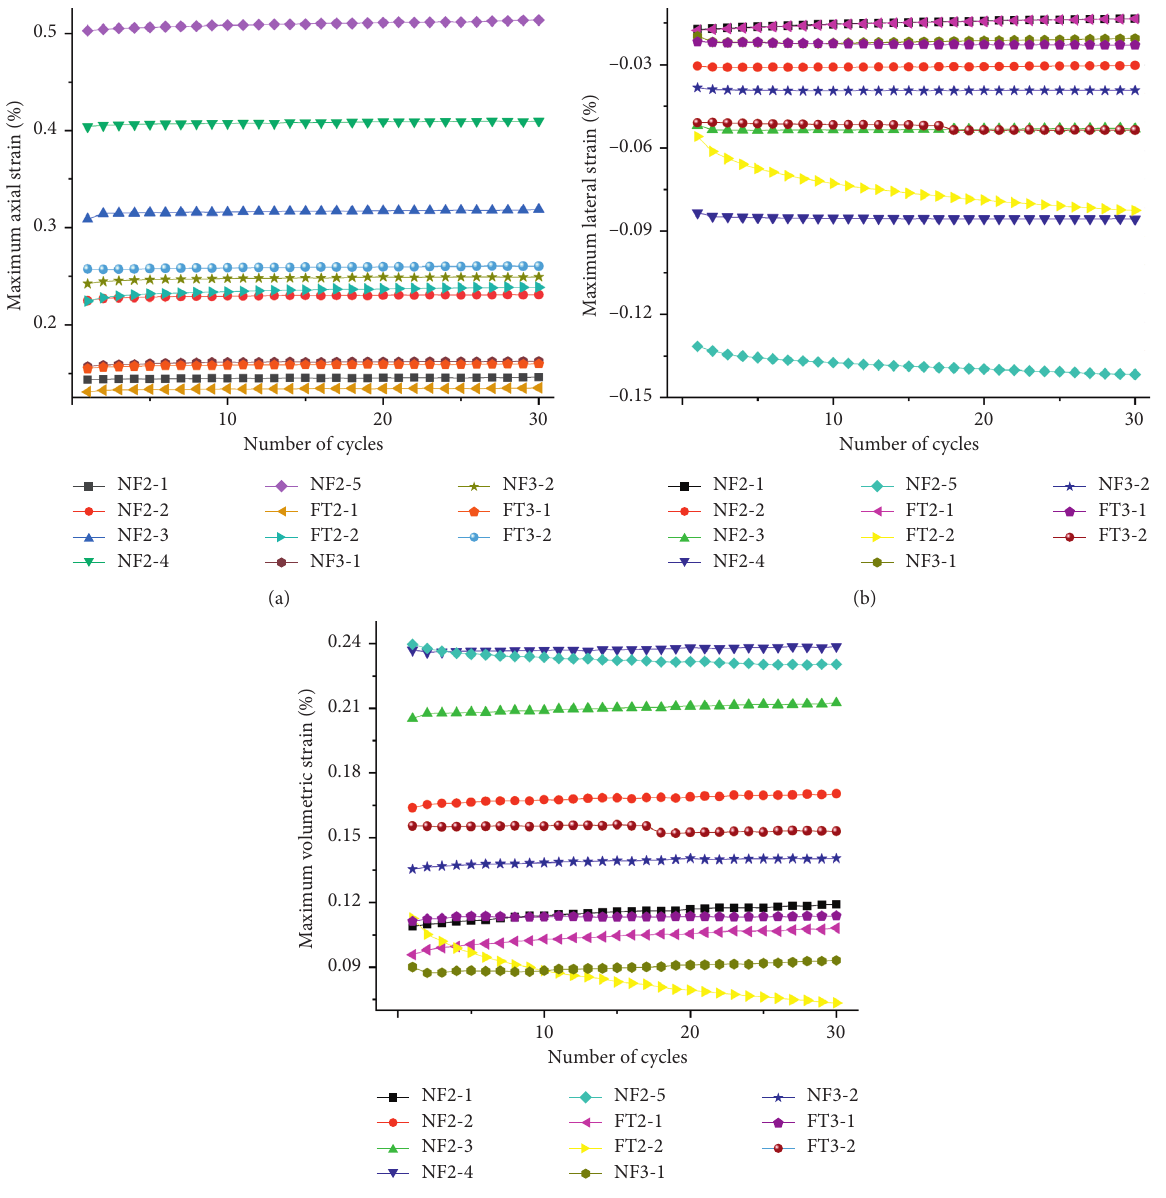
Figure 8: The relationship between the maximum strain and the number of cycles in each cyclic loading stage: (a) maximum axial strain; (b) maximum lateral strain; (c) maximum volumetric